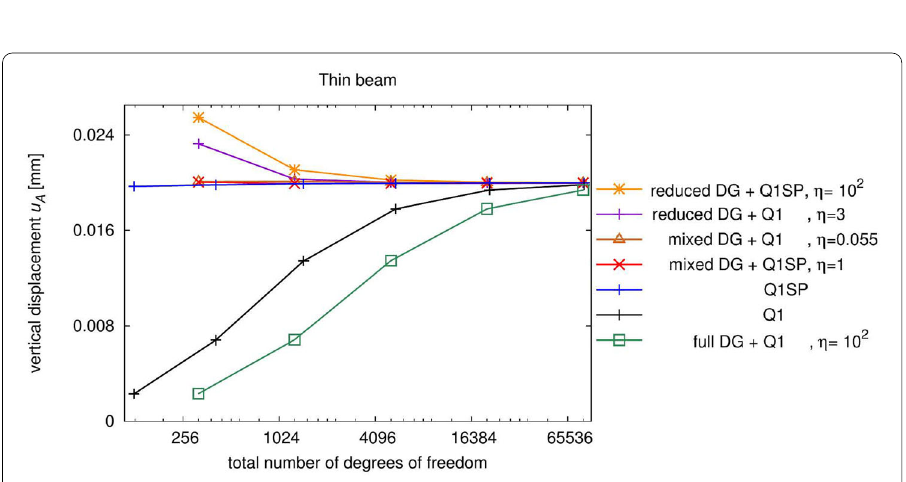
Fig. 7 Vertical displacement of the point P as a function of the total number of degrees of freedom for Q1, Q1SP, DG and their